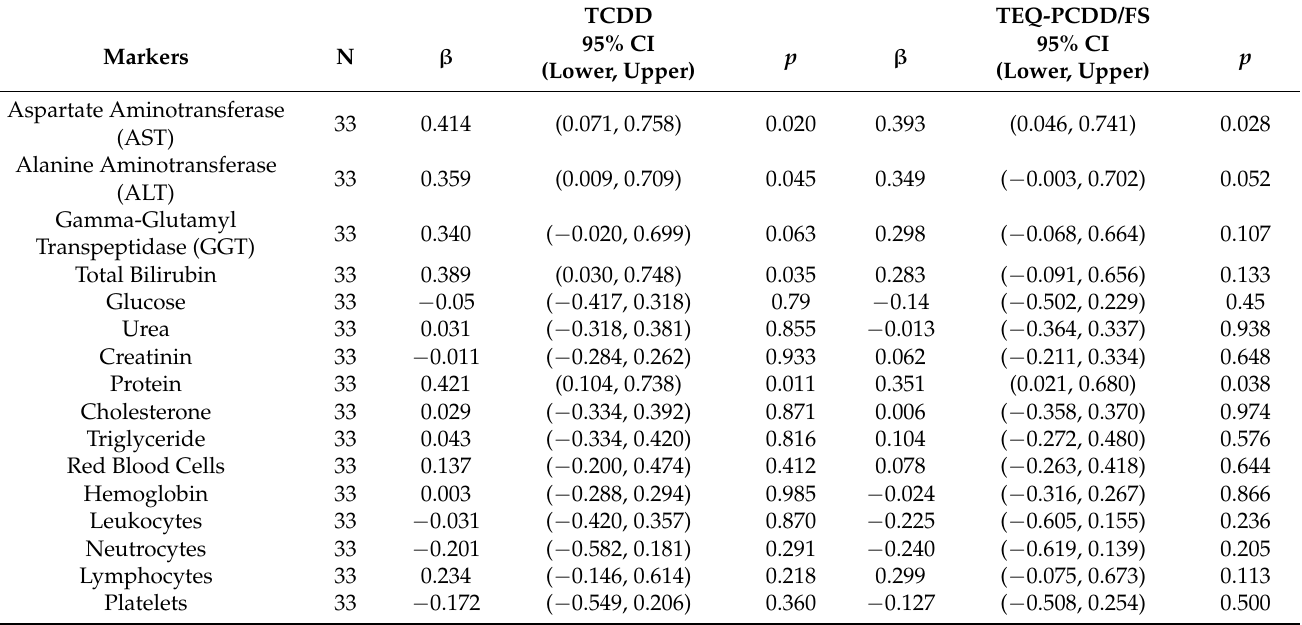
Table 2. Associations between TCDD and TEQ-PCDD/Fs concentration and biomarker indices. TCDD